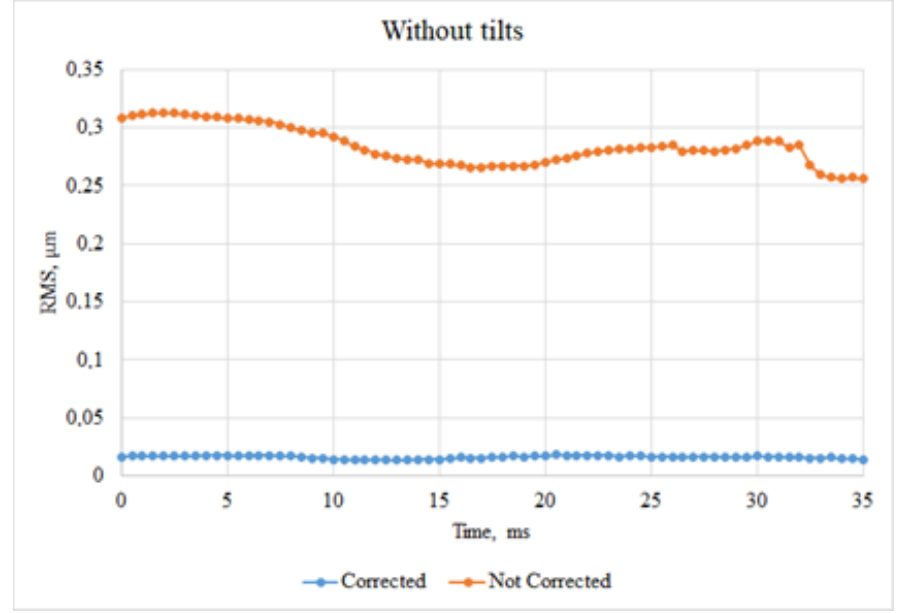
Figure 9. Residual RMS changes over time, without tilts.